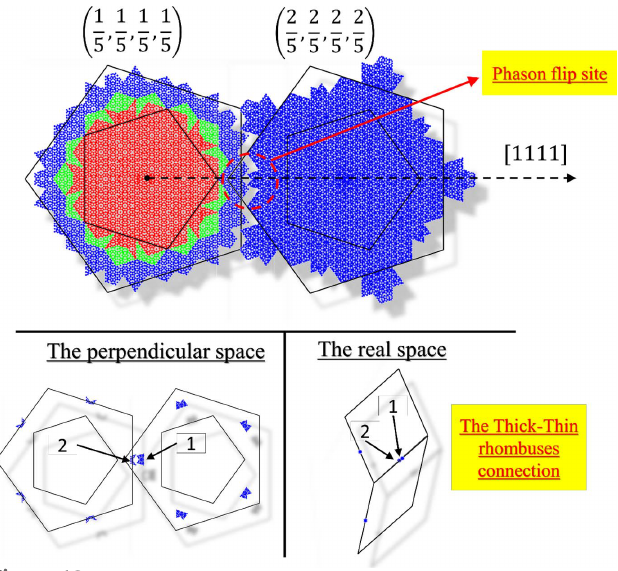
Figure 13 Recovered atomic surfaces for the decagonite structure. Red –TM atoms, blue – Al atoms and green – mixed atoms. The partially occupied sites are not differentiated in this image. The phason flip domain in the atomic surfaces is highlighted by the red circle. The domain corresponds to Al atoms located at the edges of rhombi.